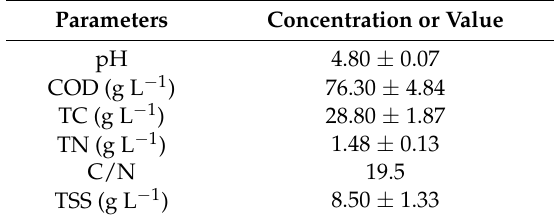
Table 2. Characteristics of distillery spent wash (DSW) from Distillerie Rivi è re du M â t, Reunion Island (COD: chemical oxygen demand; TC: total carbon; TN: total nitrogen; C/N: carbon/nitrogen ratio; TSS: total suspended